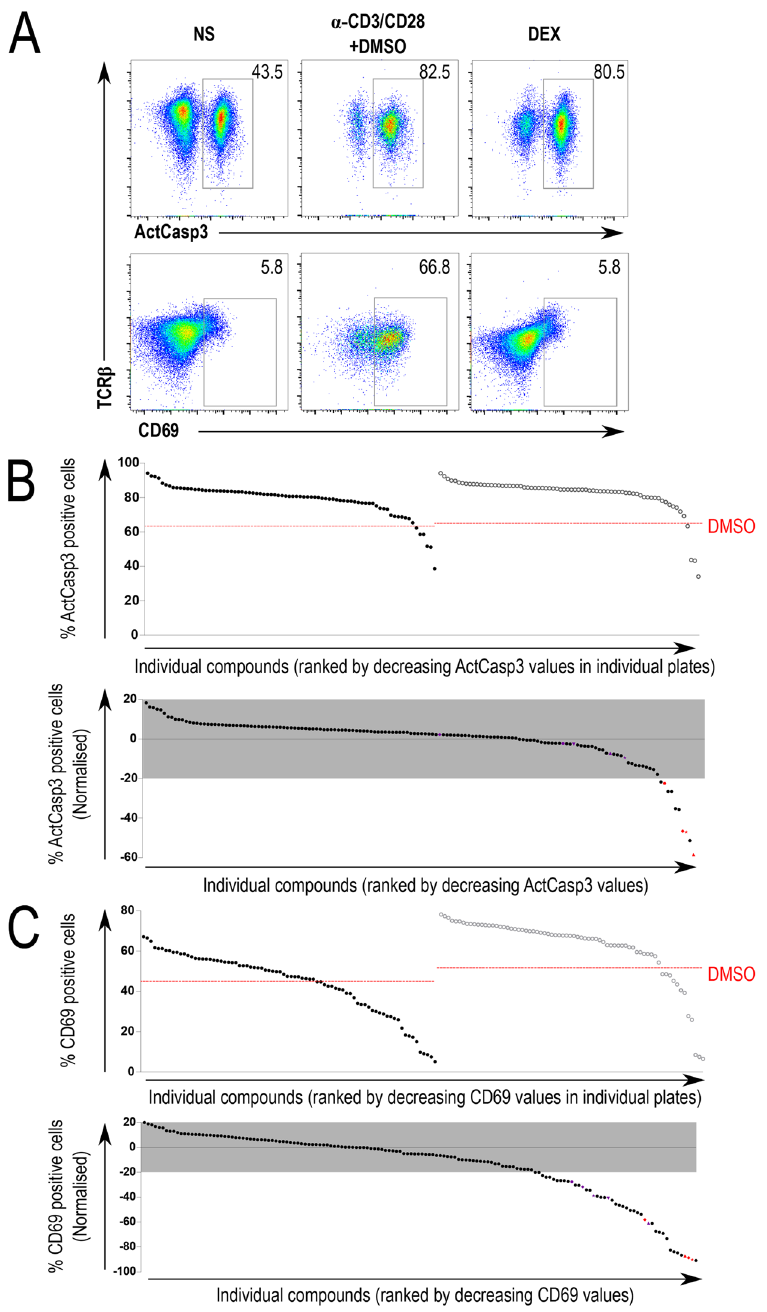
Figure 2. Functional screening of thymocyte activation. ( A) Gating strategy and controls. Flow cytometry plots showing active caspase 3 (ActCasp3), CD69, and TCR β staining within the thymocyte DP gate. Representative plots for each condition were selected from a set of quadruplicates. NS: Non-stimulated; α -CD3/CD28 + DMSO: Samples stimulated with CD3/CD28-coated beads and treated with DMSO; DEX: dexamethasone-treated samples. (B,C) Complete data from the functional screen. Thymocytes were stimulated with anti-CD3/CD28 beads for 18 h, surface stained for CD4, CD8 and CD69, permeabilized, and stained for intracellular active caspase 3. Graphs show the percentage of cells positive for active caspase 3 (ActCasp3; panel B) or CD69 expression (panel C), arranged in order of decreasing value. Raw values (top rows) and values normalized to controls (bottom rows) are shown separately for both active caspase 3 and CD69. The red lines in the raw data charts represent the average value of the DMSO-treated stimulated samples for each experiment. Normalized values are obtained by normalizing individual values to the DMSO-treated stimulated samples. An empirically selected window of ± 20% is highlighted in grey in the normalized charts to represent the compounds that were filtered out. Colored symbols represent compounds detailed in Figs 3 and